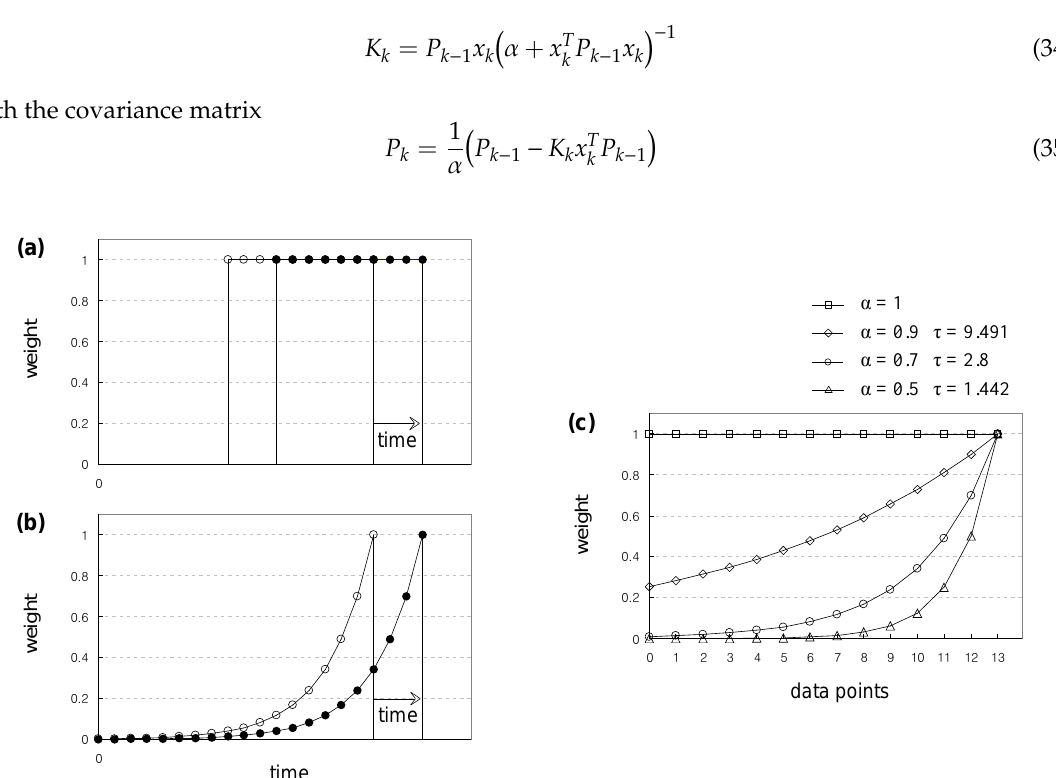
Figure 3. Comparison of ( a ) moving rectangular window and ( b ) exponentially weighted window. ( c ) E ff ect of forgetting factor α on the shape of the memory in the recursive estimator. The exponentially fading memory is characterized by a decay time constant τ